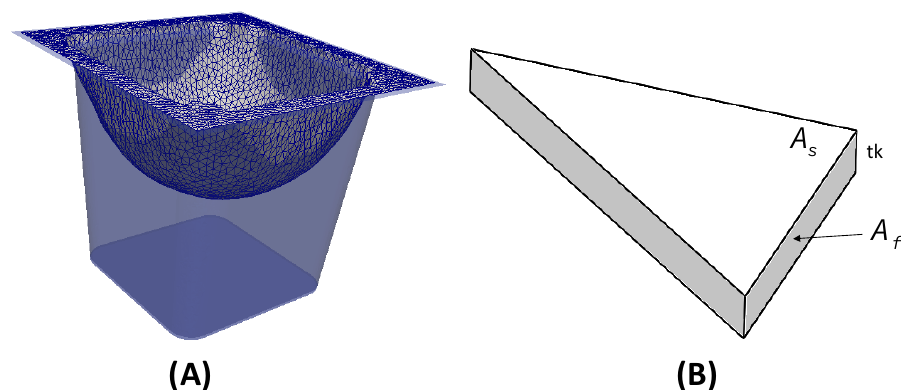
Figure 5. Geometry and illustrative mesh ( A ) and computational cell ( B ) of the polymeric sheet.